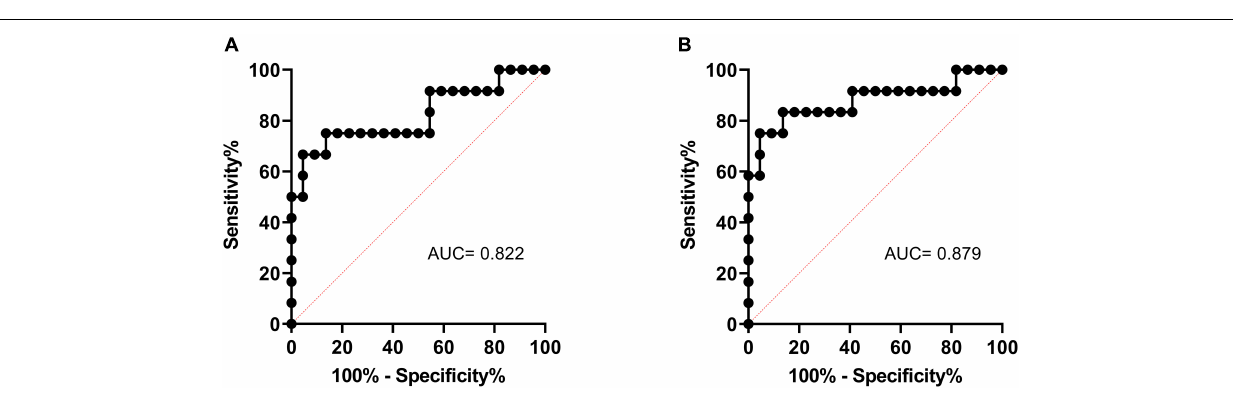
and baseline medullary R2 ∗ value ( r = 0.483; P = 0.004; Figure 3B